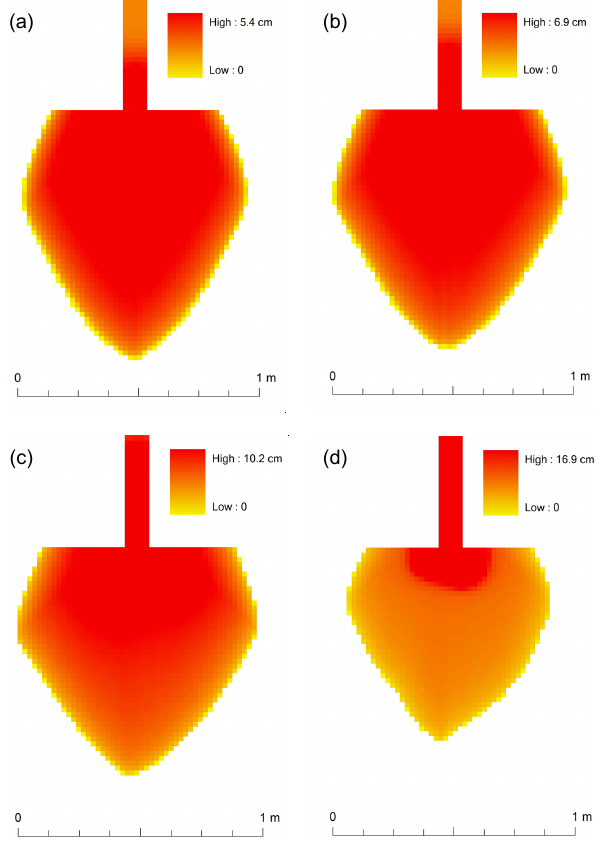
Figure 14. Location of the study area and a satellite image shortly after the Xiaojiagou debris